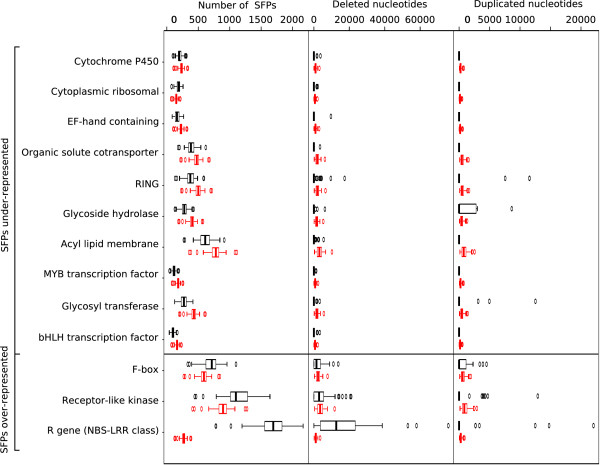
Number of SFPs in selected gene families. Of the available gene families in Additional File 1, Table S3.1, 13 are shown here that have been investigated in previous studies for comparison purposes. The observed number (black) of SFPs in a gene family is compared to the expected number (red) due to random chance. Gene families are sorted by the significance of the difference between observed and expected SFP numbers. All gene families show significantly different observed SFPs than expected except for RING genes (Additional File 1, Table S3.1). Deletions follow a similar pattern to SFPs by removing the most nucleotides from resistance, F-box and receptor-like kinase genes but differ by removing fewer nucleotides from cytoplasmic ribosomal genes. Duplications rarely occur in any of the chosen gene families. Although they do occur in resistance genes, the difference between observed and expected is not significant.